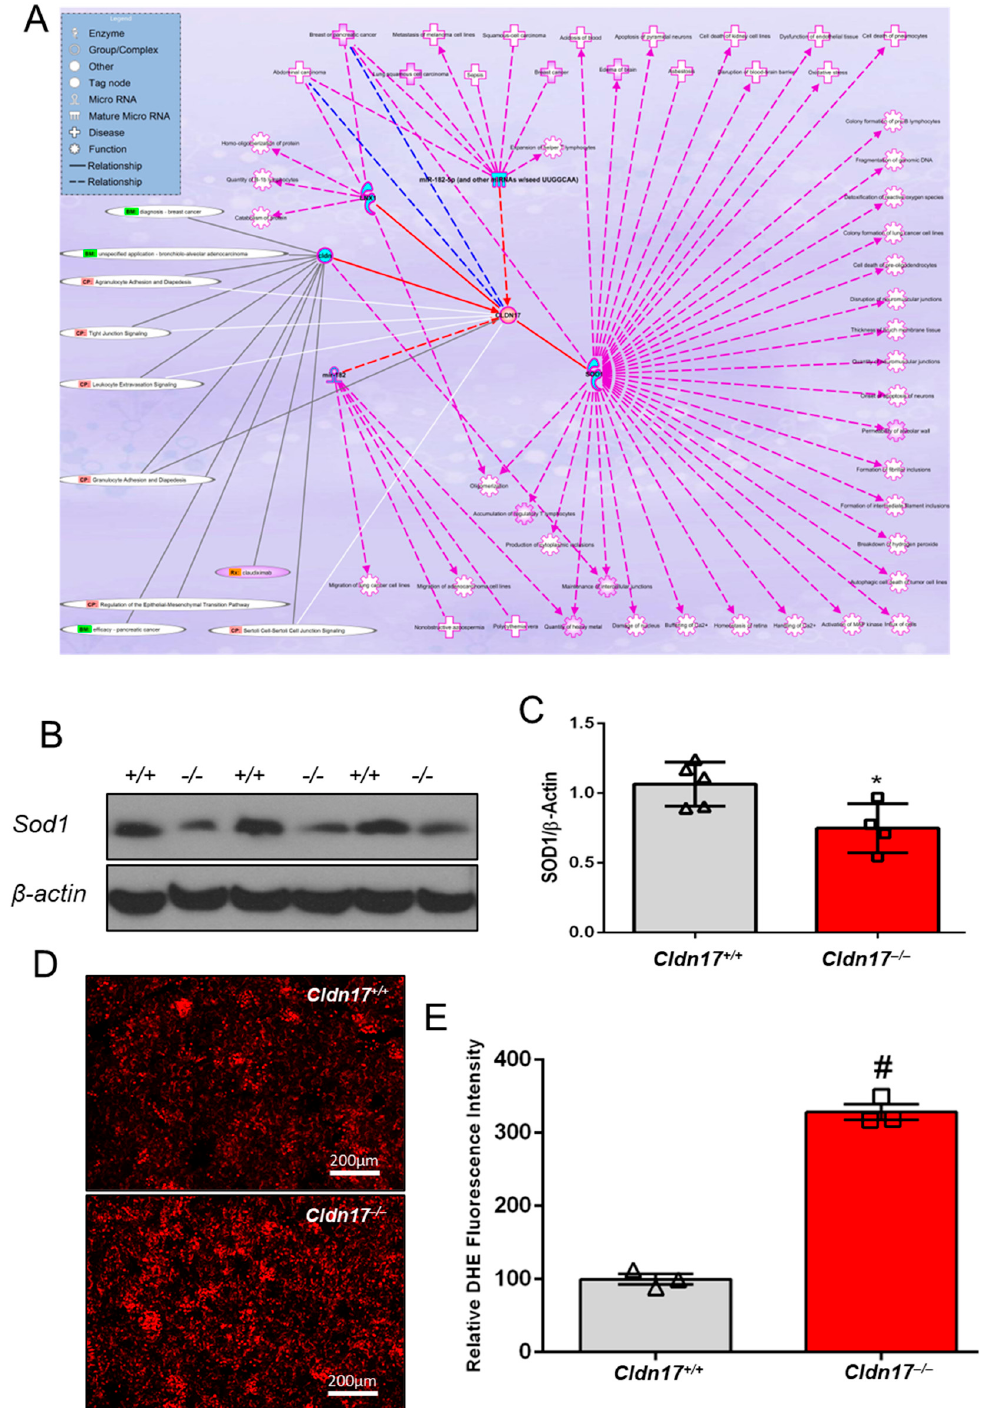
Figure 7. Cldn17 loss modulates SOD1 expression resulting in increased reactive oxygen species levels in the kidneys. ( A ) Ingenuity pathway analysis predicting a potential link between CLDN17 and SOD1. ( B ) Representative images of immunoblots and ( C ) densitometry analysis of SOD1 expression in kidney lysates obtained from WT and Cldn17 –/– mice. ( D ) DHE-stained images and ( E ) fluorescence quantification of ROS on frozen kidney sections from both groups of mice. Data presented as mean ± s.e.m.; GO, gene ontology; GSEA, gene set enrichment analysis; ROS, reactive oxygen species; H 2 O 2 , hydrogen peroxide; SOD1, superoxide dismutase1; DHE, dihydroethidium; * p < 0.05; # p < 0.01.